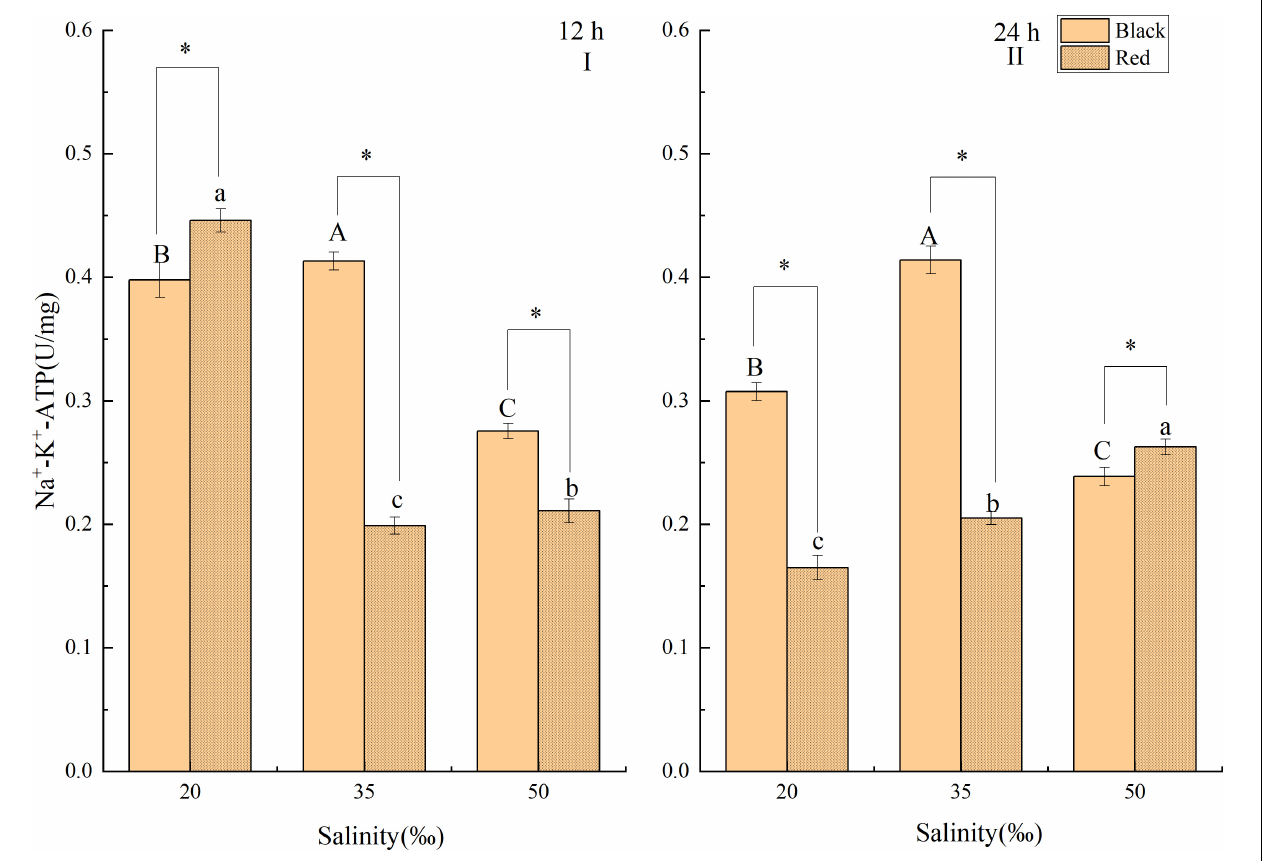
FIGURE 4 | Effects of salinity on the activity of Na + -K + -ATPase in the gill tissue of P. fucata with two shell colors (I: 12h; II: 24h).